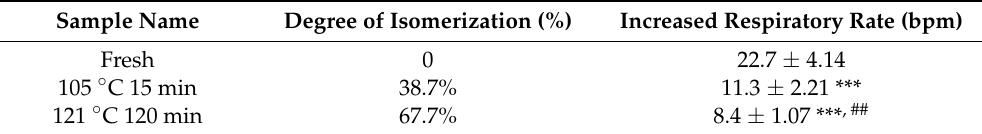
Table 2. Relationship between increased respiratory rate and degree of isomerization ( n = 10).